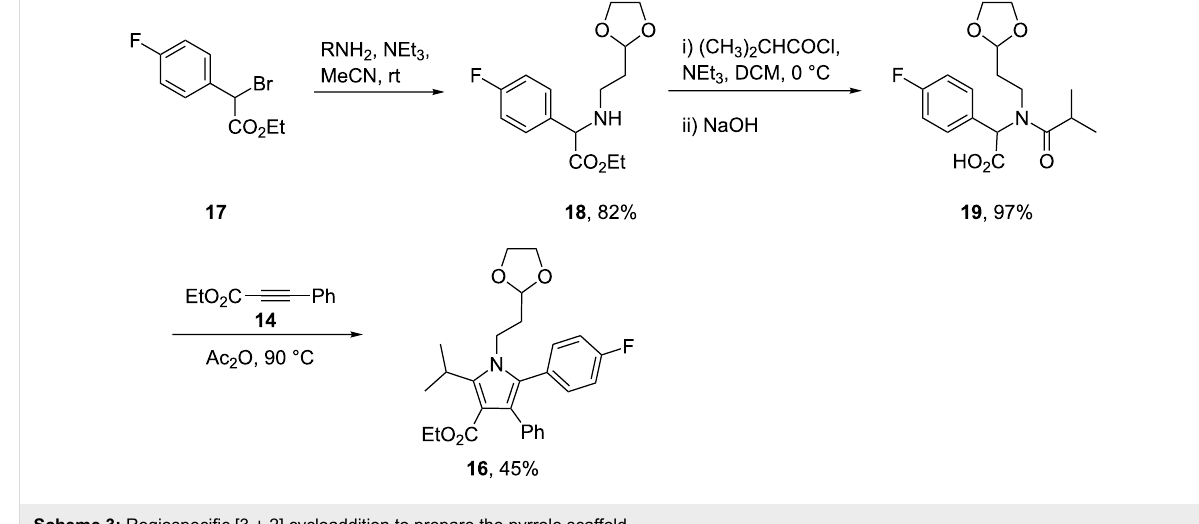
Scheme 3: Regiospecific [3 + 2] cycloaddition to prepare the pyrrole scaffold.